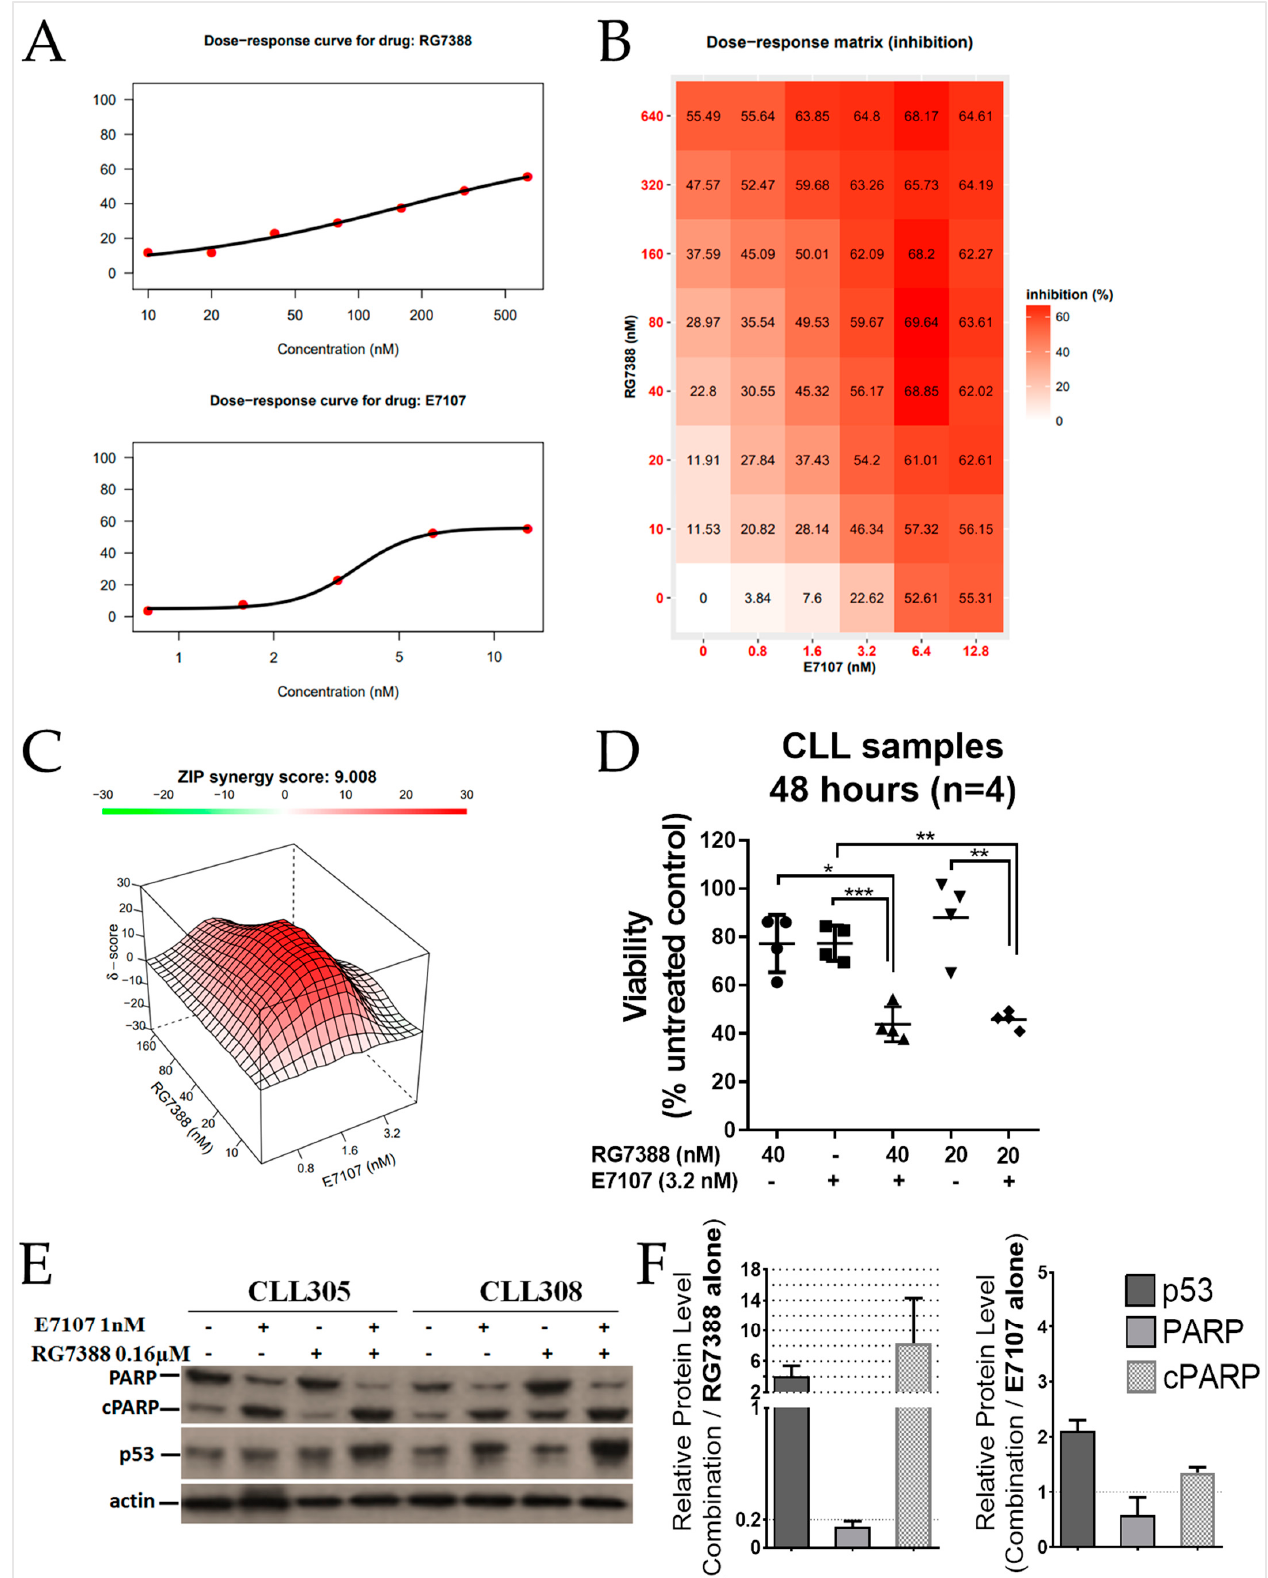
Figure 6 . Synergistic effect of RG7388 and E7107 on primary CLL samples. ( A ) Dose-dependent inhibition of cell viability determined by XTT assay averaged for n = 4 patient CLL samples after 48 h